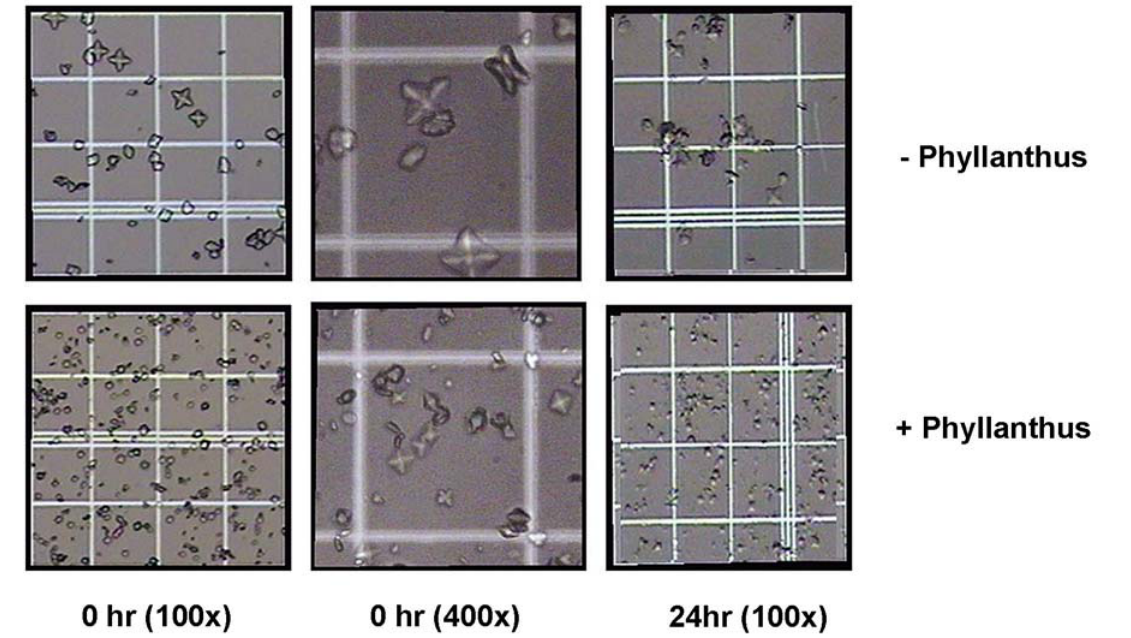
Figure 2 – Light microscopy of CaOx crystals formed immediately (0 hr) and 24 hours after the addition of sodium oxalate solution in normal human urine and after in the absence and presence of Phyllanthus niruri. X100 and